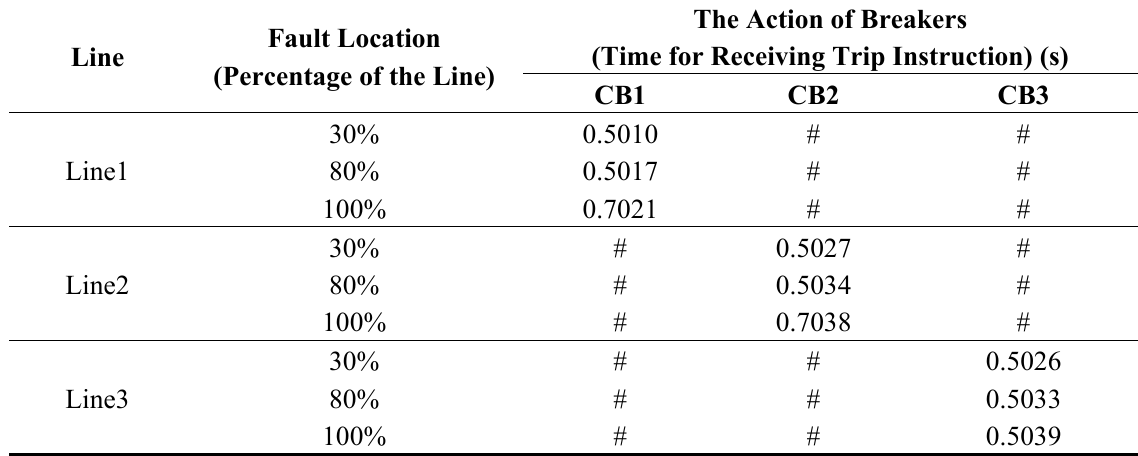
Table 2. The action situation of each